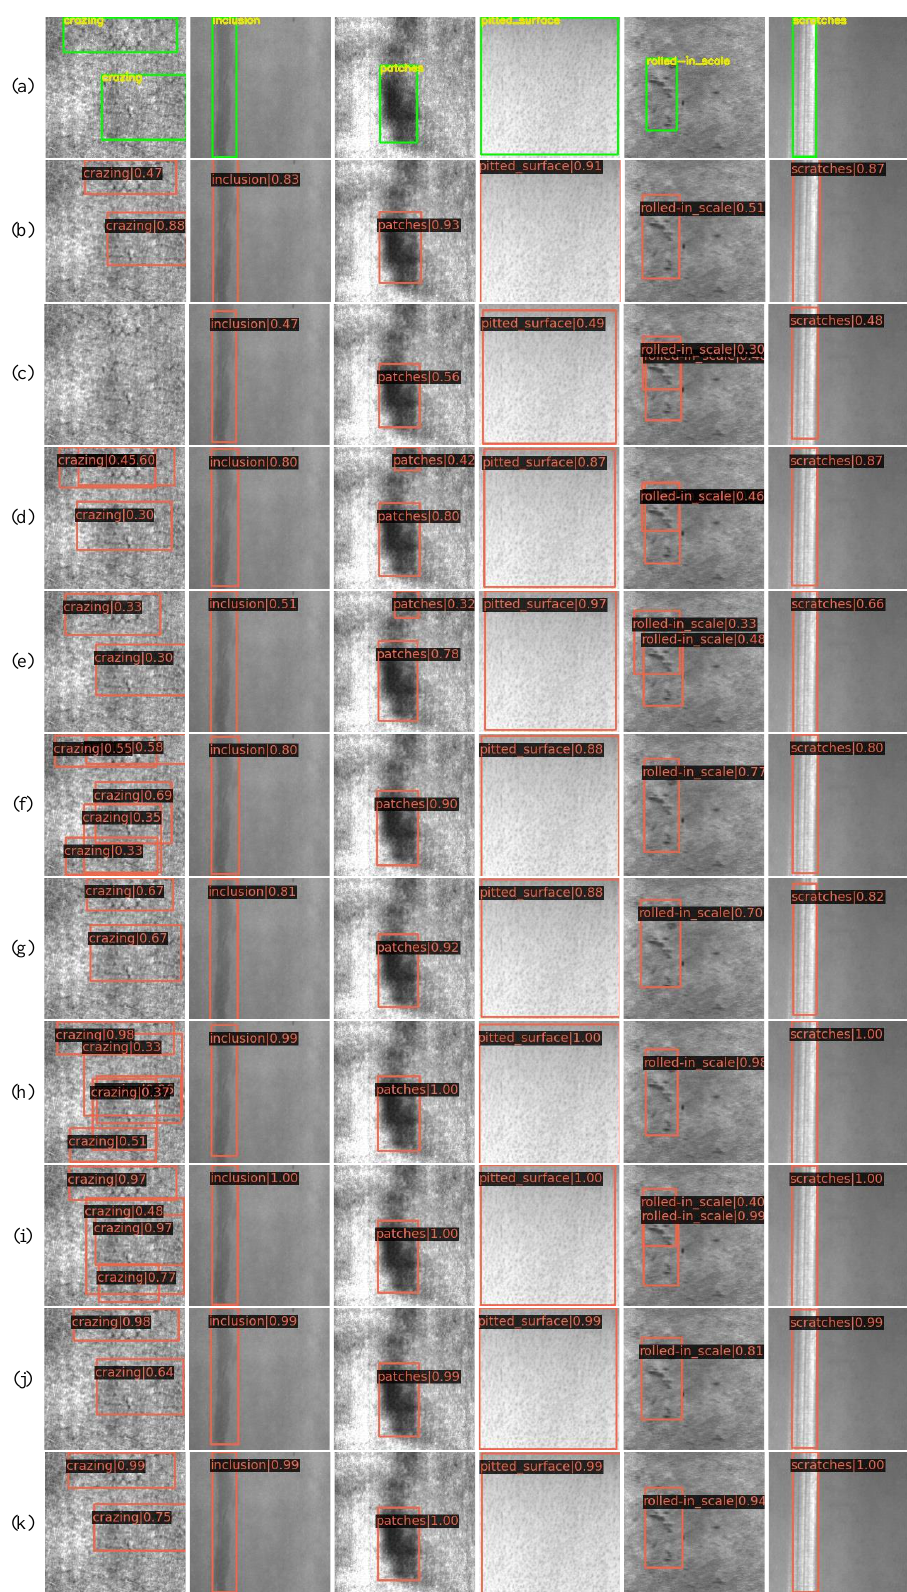
Figure 7. Comparison of detection results on NEU-DET. ( a ) Groundtruth, ( b ) YOLOv3, ( c )